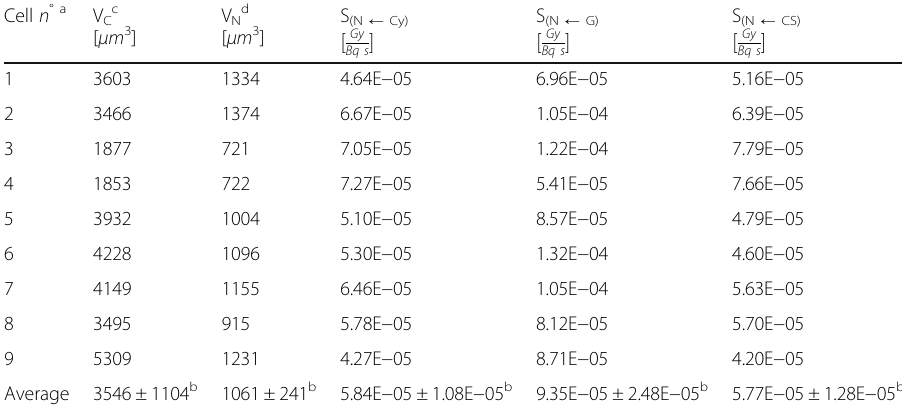
Table 2 Self-dose from cytoplasm, Golgi, and cell membrane to nucleus for each of the 9 PM